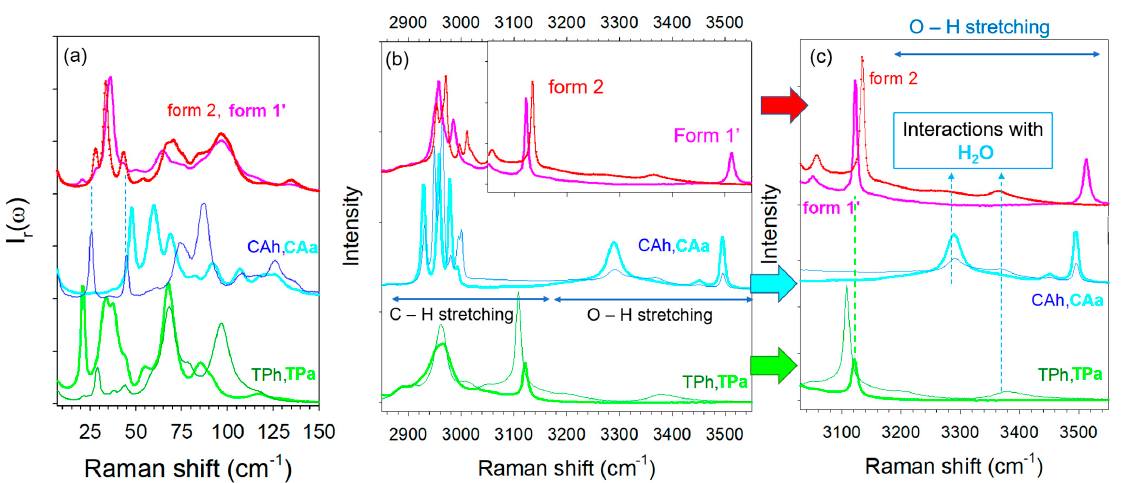
Figure 2. Raman spectra of the two pseudo polymorphic forms of co-crystals, form 1 ′ , form 2, and single components: anhydrous and hydrated theophylline (TPa, TPh), anydrous and hydrated citric acid (CAa, CAh), ( a ) in the low-frequency region, ( b ) in the C–X stretching region (X = C, O), ( c ) in the O–H stretching region.